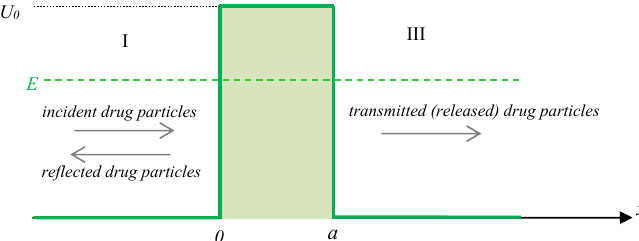
Figure 2. The three physical regions of a potential barrier of height U 0 and width a ( E represents the energy of the incident drug particle).